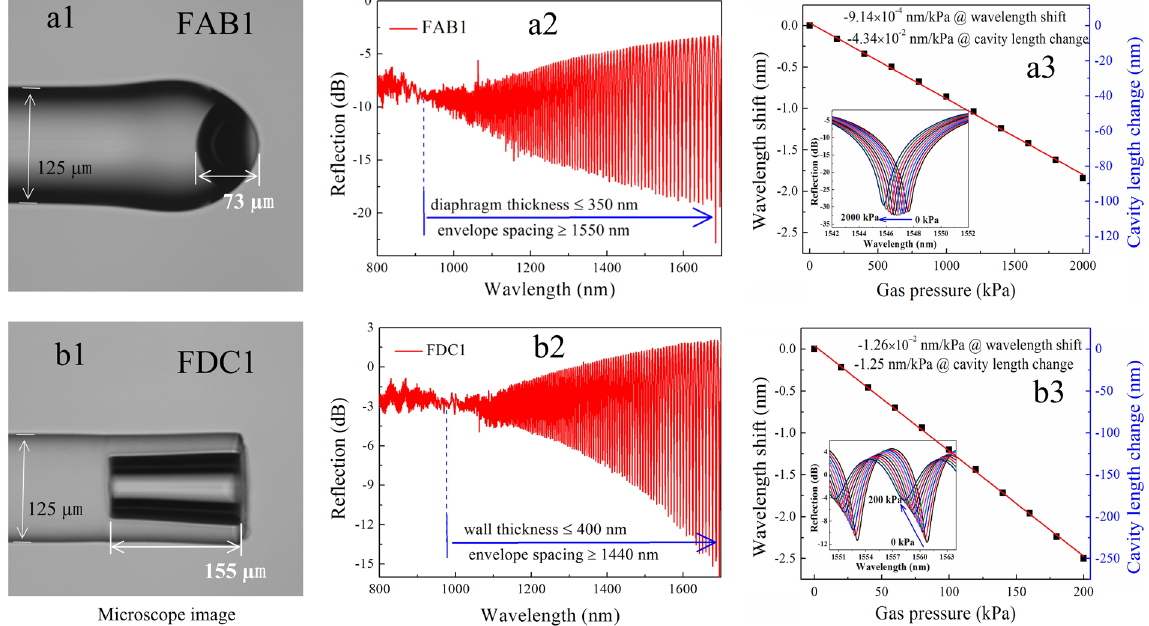
Figure 3. Pressure responses of two types of FPI-based gas pressure sensor specimens employing an FAB or an FDC. ( a1 ) Optical microscopy image of specimen FAB1 employing an FAB with a diaphragm thickness of about 350 nm, as calculated from the envelope spacing of its reflection spectrum given in ( a2 ). ( a3 ) Wavelength shift of the interference fringe around 1550 nm with the gas pressure varying from 0 to 2.0 MPa, and the slope of the linear fitting is about 9.14 × 10 − 4 nm/kPa, reflecting a corresponding gas pressure sensitivity of about 4.34 × 10 − 2 nm/kPa. The inset presents the reflection spectral evolution. ( b1 ) Optical microscopy image of specimen FDC1 employing an FDC with a diaphragm thickness of about 400 nm, as calculated from the envelope spacing of its reflection spectrum given in ( b2 ). ( b3 ) Wavelength shift of the interference fringe around 1550 nm with the gas pressure varying from 0 to 0.2 MPa, and the gas pressure sensitivity is about 1.25 nm/kPa. The inset presents the reflection spectral